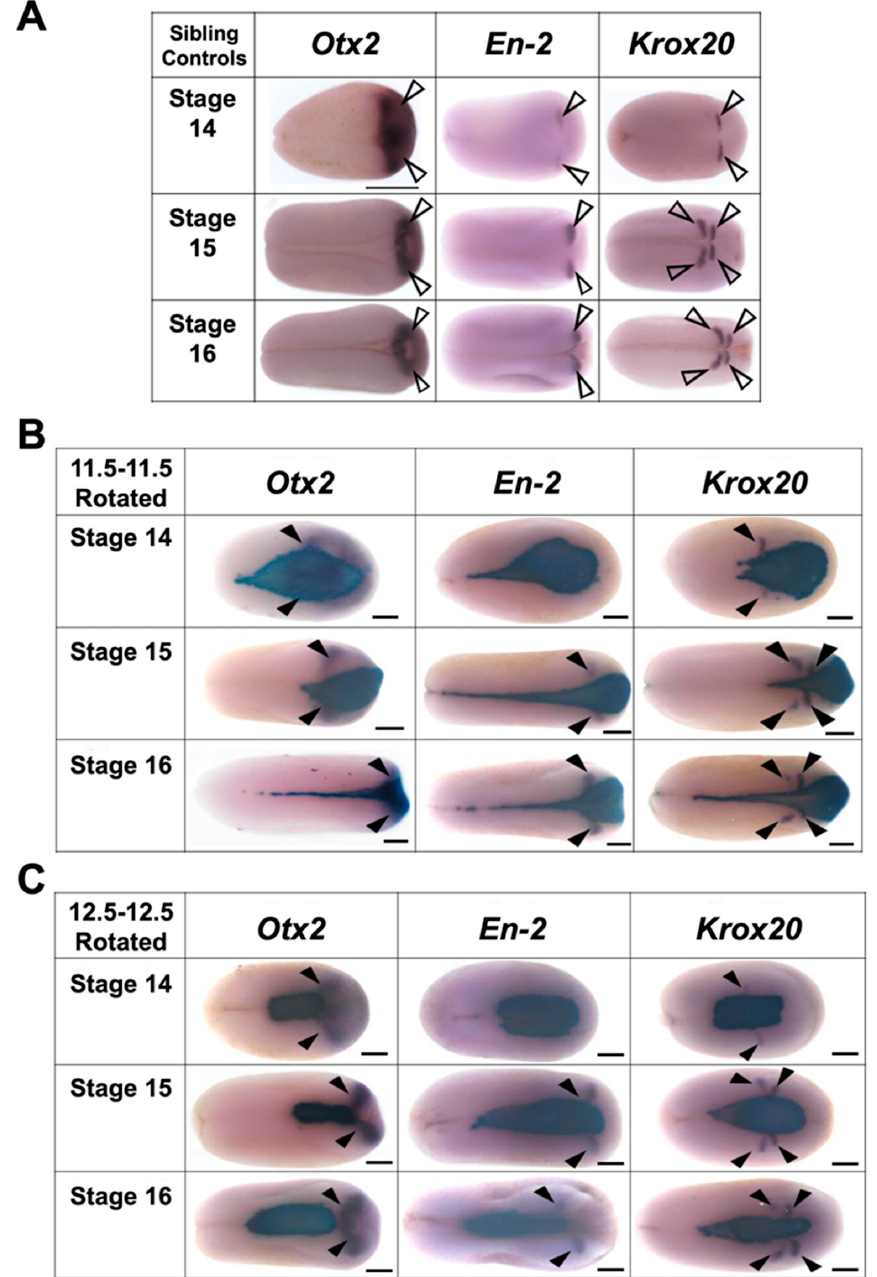
Figure 11. Representative examples of expression of regional marker genes in ( A ) sibling control embryos, ( B ) mid-gastrula rotated transplants, and ( C ) late gastrula rotated embryos at stages 14 to 16. Dorsal view for all embryos, anterior is to the right. Purple stain marked with a solid arrowhead indicates gene expression and blue stain indicates transplant incorporation. Scale bar represents 250 μ m.